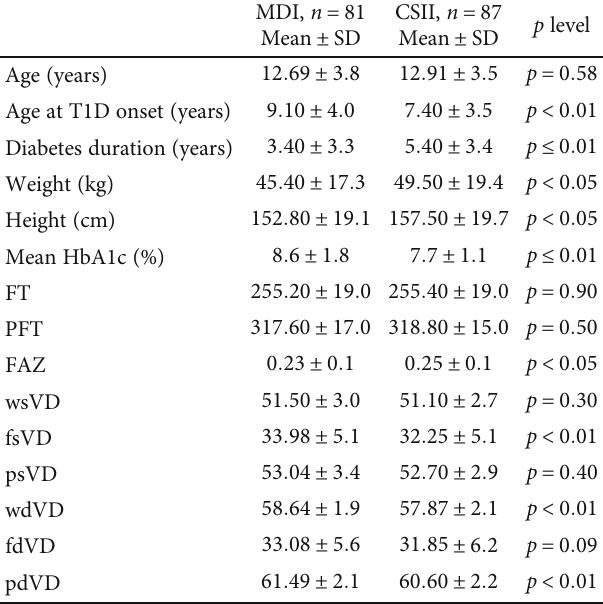
Table 2: Comparison of the groups treated by MDI or CSII. MDI, n = 81 Mean ±